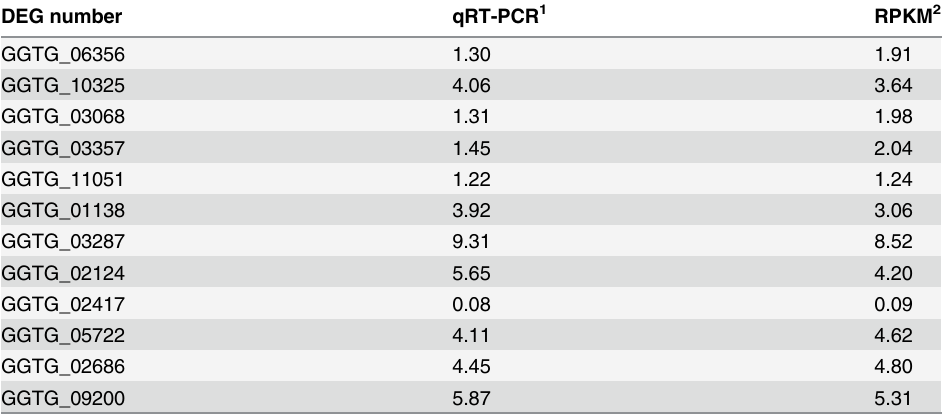
1 qRT-PCR ratio was determined from the log2 of the − ΔΔ CT values from the Ggt -infected wheat root sample divided by that from the Ggt in culture 2 RPKM ratio determined by the log2 of the RPKM value from the Ggt -infected wheat roots divided by that of the Ggt culture